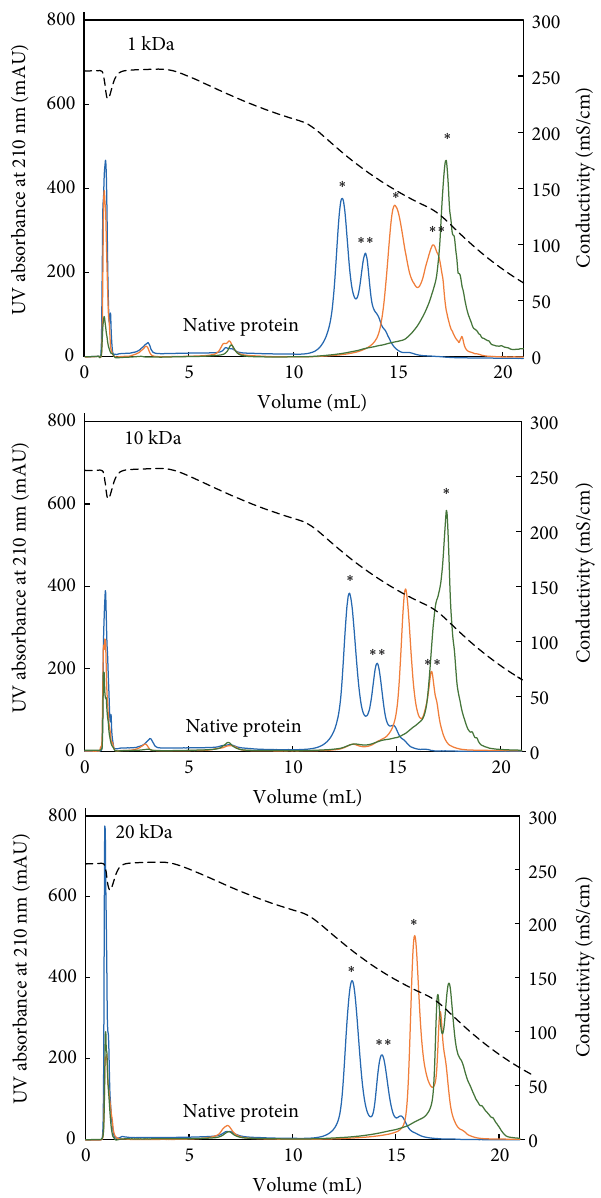
Figure 2: Separation of PEGylated Ribonuclease A using PEGylated monoliths. Chromatogram at 215 nm of Ribonuclease A PEGylation reactions with different PEG molecular weights 5.0 (blue line), 20.0 (orange line) and 40.0 kDa (green line) were separated using PEGylated monoliths modified with different PEG molecular weights 1.0, 10.0, and 20.0 kDa. Each experiment was carried out by triplicate. Conductivity was also measured and is presened in mono-PEGylated protein, the chromatograms (black dashed line). di-PEGylated ∗ ∗∗